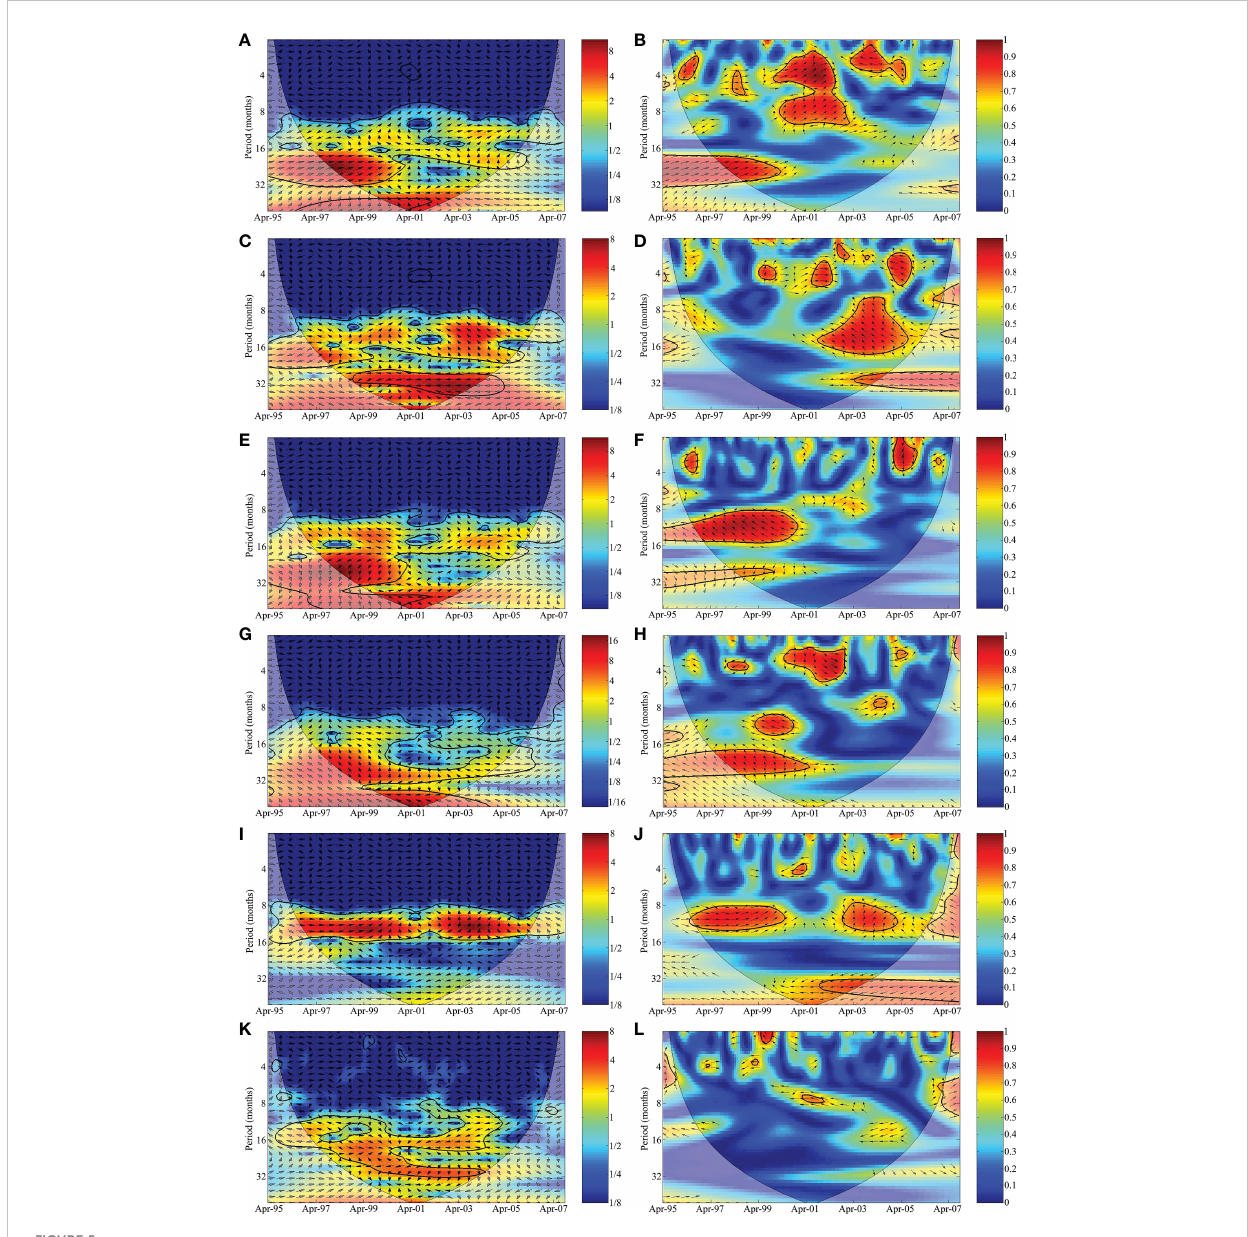
FIGURE 5 Cross-wavelet and coherence wavelet analysis between the shark bycatch landed by the acoupa weak fi sh ( Cynoscion acoupa ) gillnet fi sheries in Para ́ state and the anomalies of (A, B) sea surface temperature (SST), (C, D) the meridional wind component (v), (E, F) the discharge of the Amazon River (ARD), (G, H) the Atlantic multidecadal oscillation (AMO), (I, J) Atlantic Ocean Inter-hemispheric Sea Surface Temperature Gradient Index (GITA), and (K, L) the Multivariate El Niño Index (MEI). The 5% signi fi cance level for red noise is shown as a thick contour (the cone of in fl uence). The relative phases are shown as